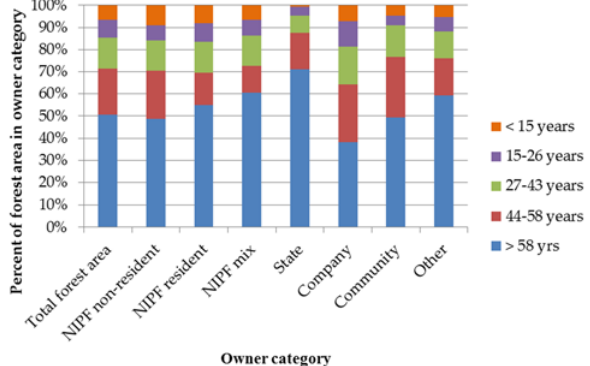
Figure 6. The distribution of forest age within forest owner categories in our focus study area within Vilhelmina municipality, Sweden. Note that data on owner category refers to the situation in January 2016. Land ownership is categorized into State, Company (large-scale forest companies), NIPF resident and NIPF non-resident (non-industrial private forest owners identified as living in or outside the municipality), NIPF mix (a mix of NIPF resident and NIPF non-resident owners), Community (a large forest common, the municipality, and some smaller village commons) and Other (the church, foundations, and unidentified owners).